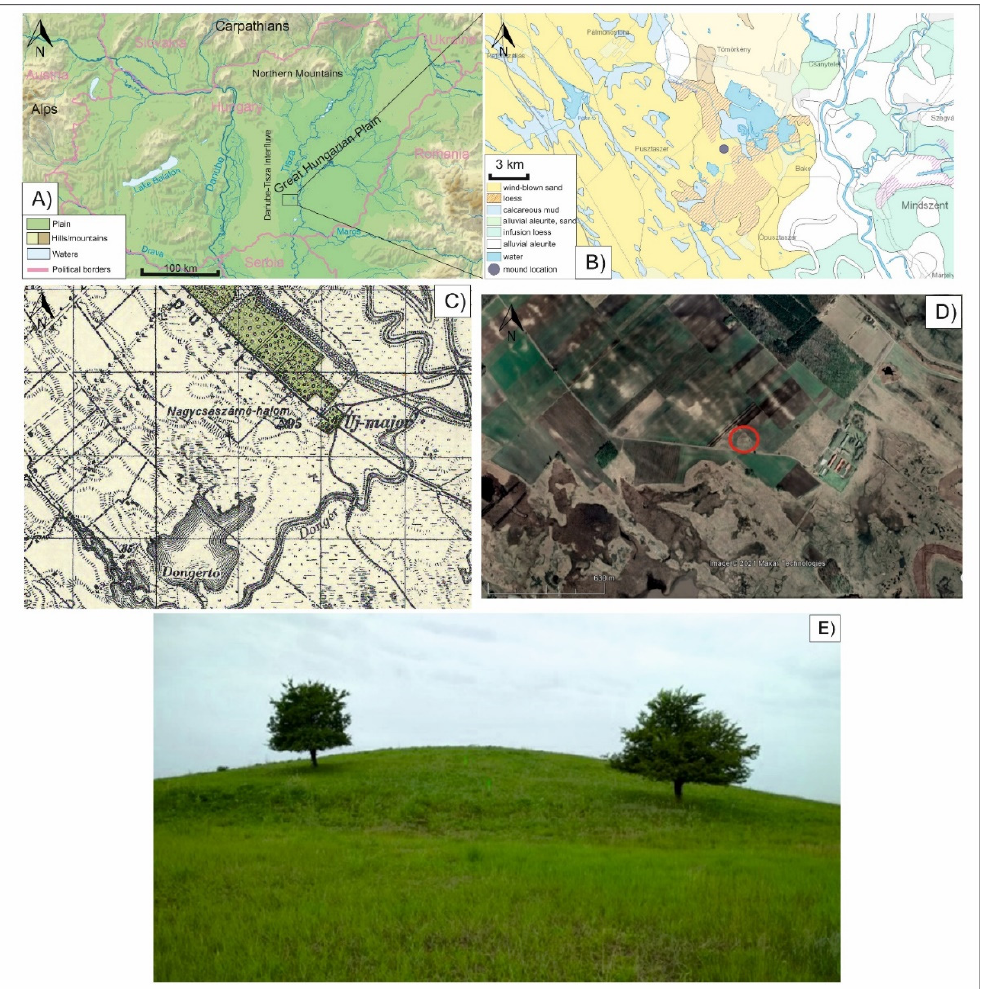
Figure 2. ( A ) Location of the Császárné Mound in Hungary [38], ( B ) Surface geological map of the vicinity of the study area [39] ( C ) The mound on the topographic map of Hungary in the period of World War II., [40] ( D ) Satellite image of the mound with its surroundings [41], ( E ), Császárné Mound (from the South) [Authors].